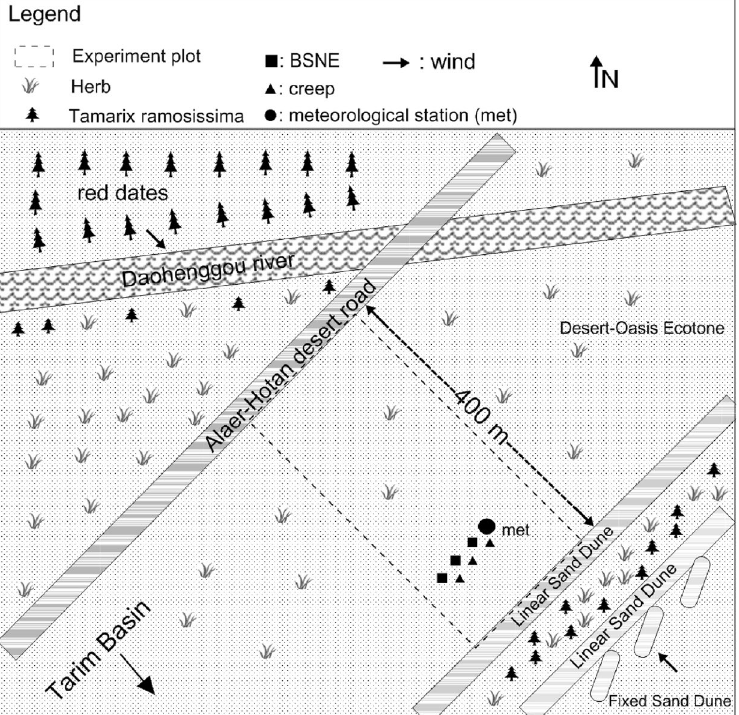
Figure 1. Location of instrumentation in the experimental plot with symbols representing placement of BSNE ( ◾ ) and creep ( ▴ ) collectors and meteorological (met) station (Generated by Adobe Photoshop 12.0, http://